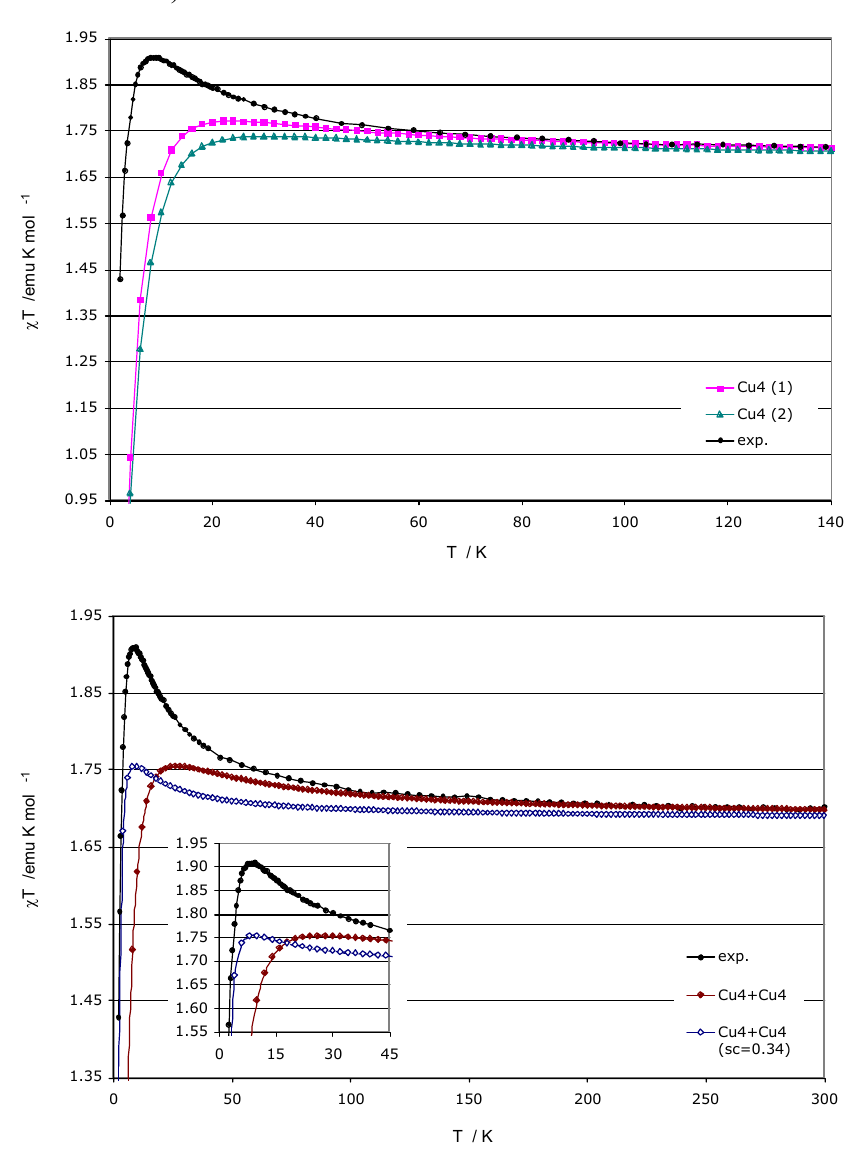
Figure 7 . Variation of the magnetic susceptibility with the temperature. (a) Experimental curve (black) and computed curves for each of the two non-equivalent Cu II tetramers (purple and green, according to Figures 2a and 2b respectively); (b) Experimental curve (black) and computed curves for the two-tetramer model (8 electrons in 8 sites), without and with scaling factor (the linear scaling factor used is